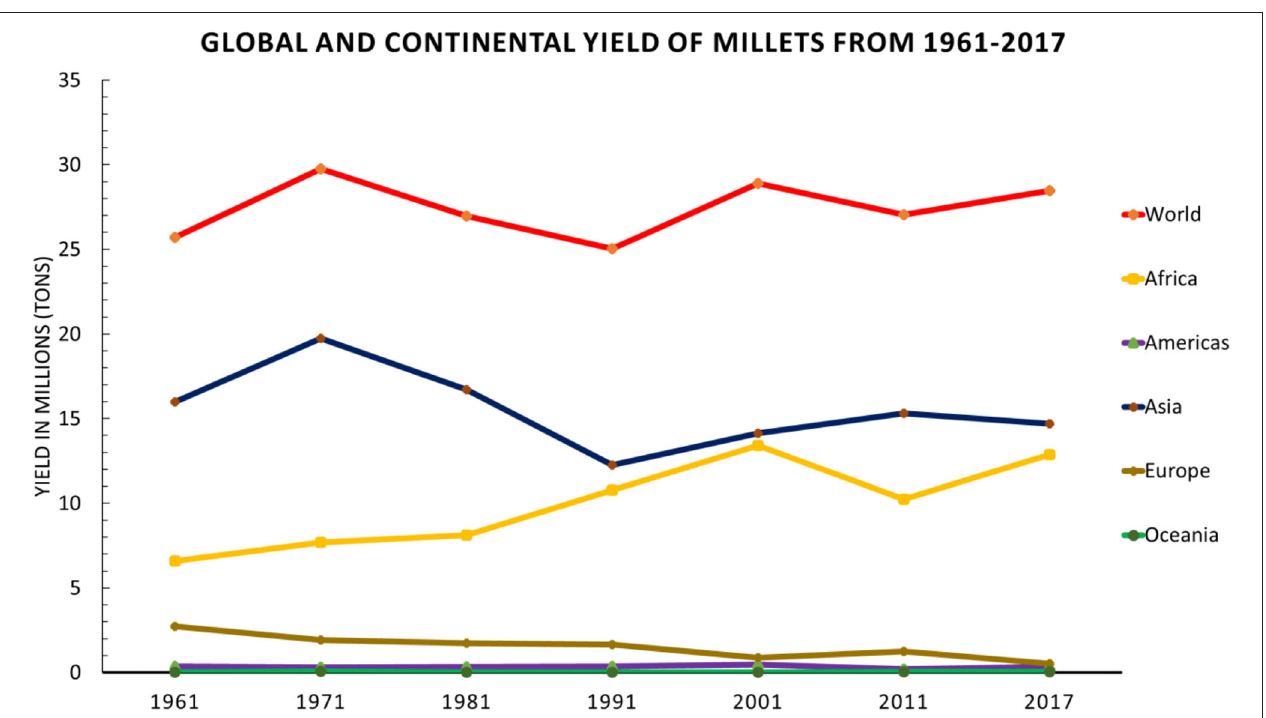
FIGURE 1 | Global and Continental Yield of Millets from 1961 to 2017 (FAOSTAT, 2019).